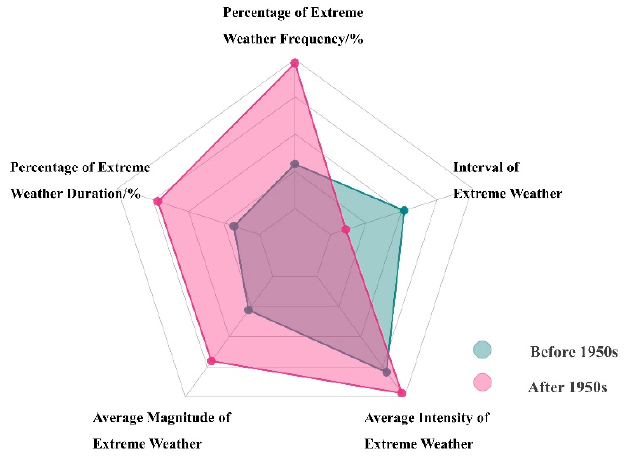
Figure 7. Comparison of the frequency, interval, intensity, scale, and duration of extreme events before and after the 1950s.